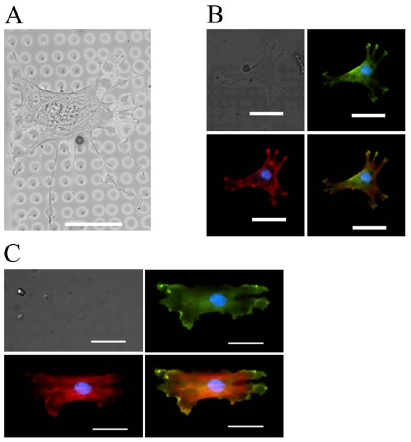
Figure 2. Hydrogel island elasticity regulates cell adhesion and spreading size in MSCs. (A) MSC adhered to pattern with 7 kPa islands, 12 kPa background elasticity, 3 m m spacing, and 100 m g ml 2 1 FN with a cell area of 2,669 m m 2 . Shown as brightfield image (top left), vinculin staining (top right), F-actin staining (bottom left), and merged image (bottom right). Average cell area for data point was 1174.54 m m 2 6 113.16 m m 2 . (B) MSC adhered to pattern with 105 kPa islands, 12 kPa background elasticity, 3 m m spacing, and 100 m g ml 2 1 FN with a cell area of 6,134 m m 2 . Shown as brightfield image (top left), vinculin staining (top right), F-actin staining (bottom left), and merged image (bottom right). Nucleus is shown in blue in all images. Average cell area for these conditions was 5847.13 m m 2 6 260.56 m m 2 . All scale bars are 50 m m.